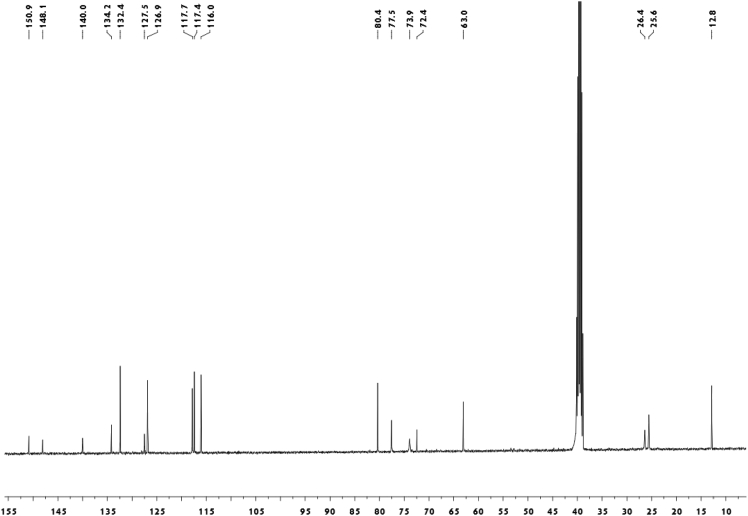
13C-NMR spectrum of meroterpenoid 2.